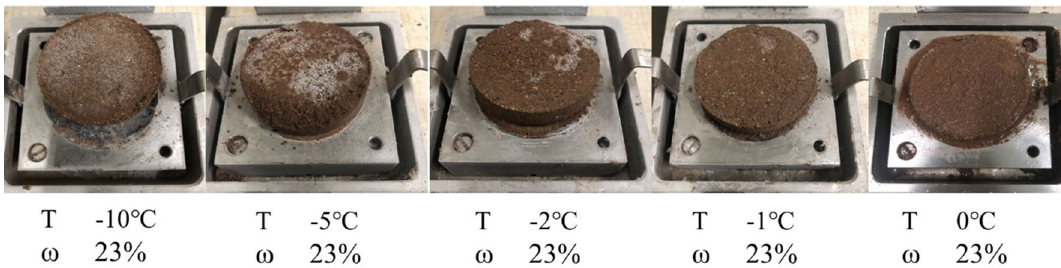
Figure 5. Morphology of the specimen after shear failure at different shear temperatures.